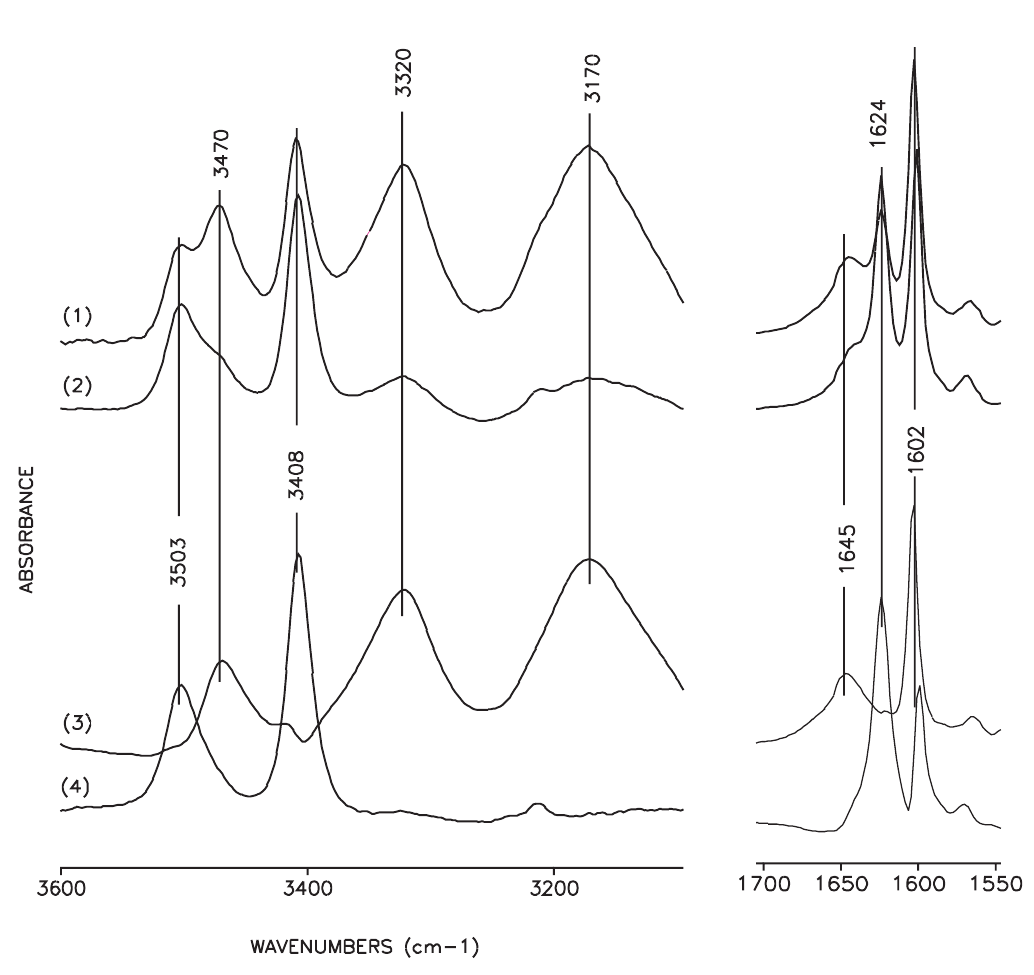
Fig. 3 NH 2 – stretching and scissoring region of 4-AP aducts with thriethylamine (TEA): molar ratio: 4-AP:TEA = 1:1 (1) and 4-AP:TEA = 1:3 (2); corresponding reduced spectra after elimination of the bands at 3503 cm − 1 (3) and 1645 cm − 1